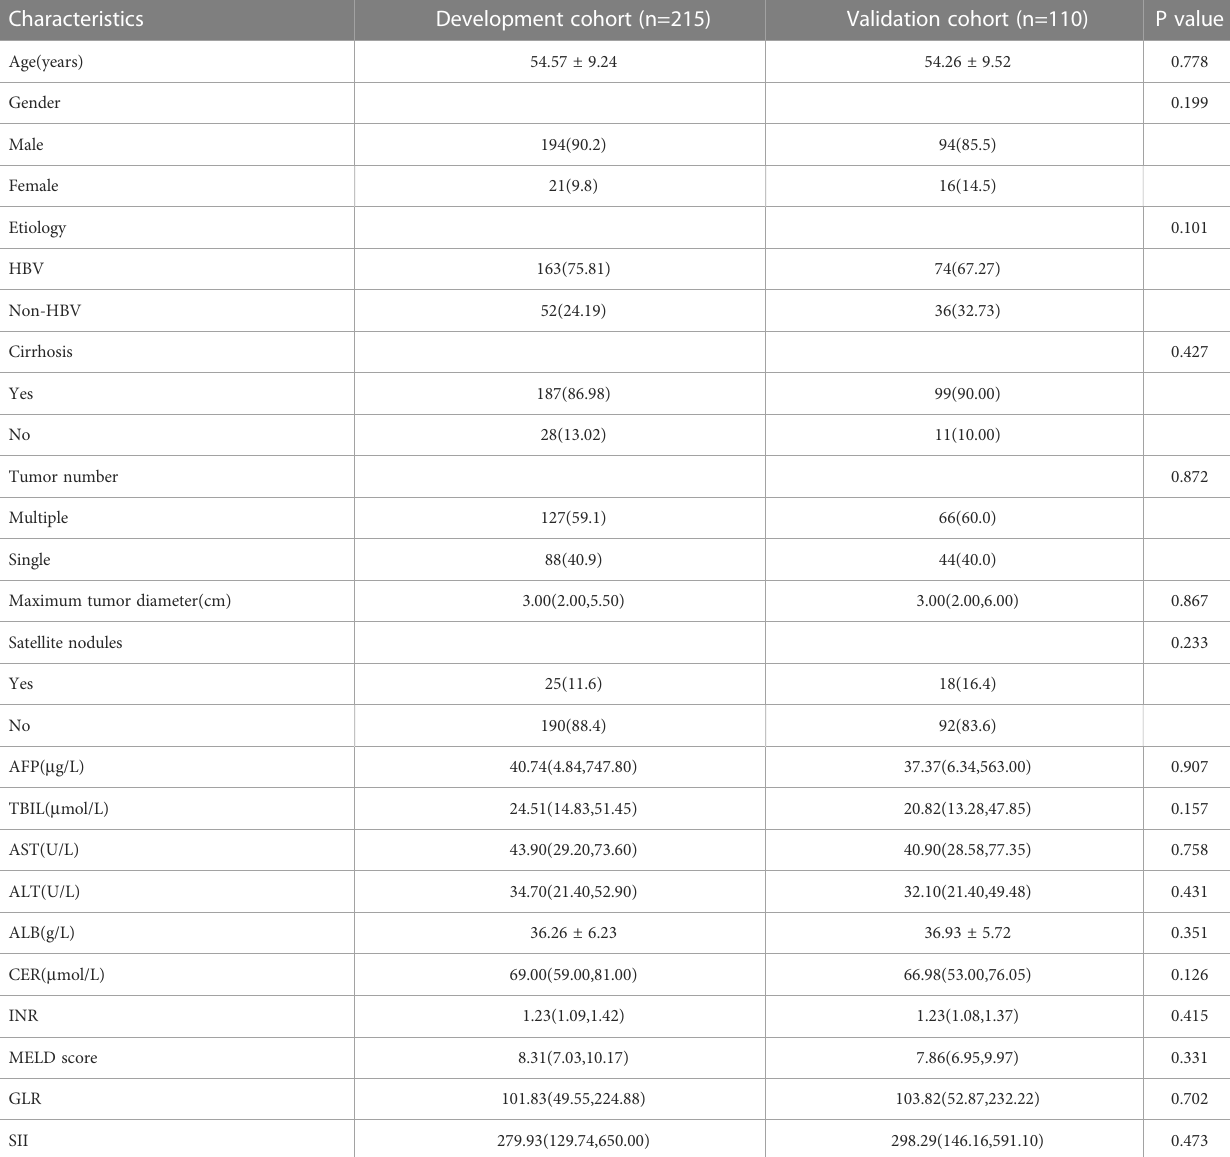
TABLE 1 The baseline data of patients in the development and validation cohorts.